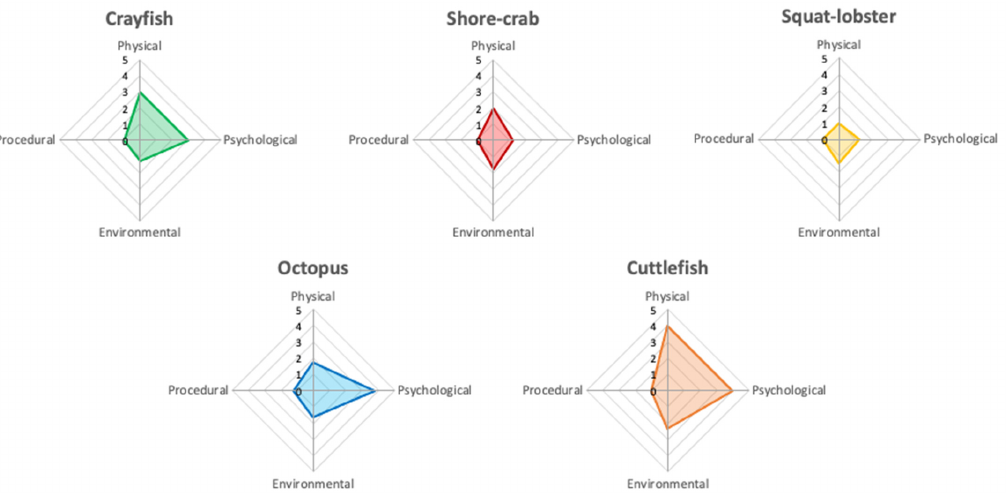
Figure 2. Averaged animal welfare assessment grids of the decapod ( top row) and cephalopod ( bottom row) study subjects. The radar charts represent the average scores for physical, psychological, environmental, and procedural parameter class over the study period on a scale from 1 to 10, with 1 being the best possible score and 10 the most detrimental. The axes in the figure are adjusted to increase clarity of the average score for each parameter class for each species. The area of the polygon presented on the radar chart equates to the CWAS value for the complete study period. Animals 2022 , 12 , x FOR PEER REVIEW 14 of 22